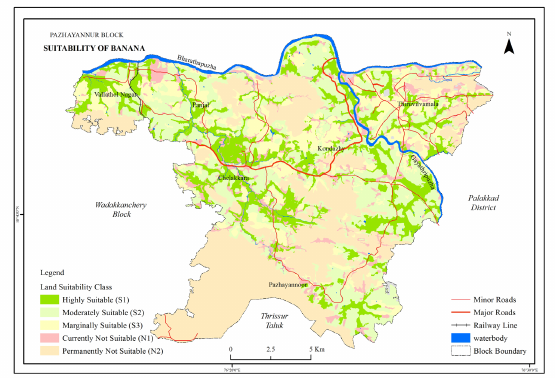
Figure 5. Land Suitability for Banana